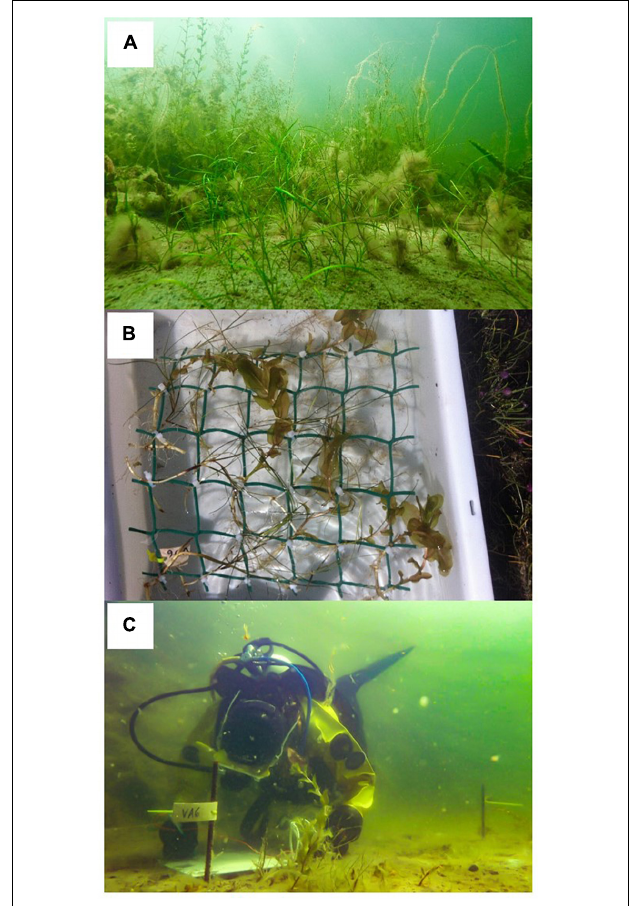
FIGURE 1 | (A) Natural mixed species aquatic plant community in the northern Baltic Sea (image credit Alf Norkko). (B) Artificial triculture community ready to be transplanted (image credit Charlotte Angove). (C) Regular monitoring of experimental communities (image credit Tiina